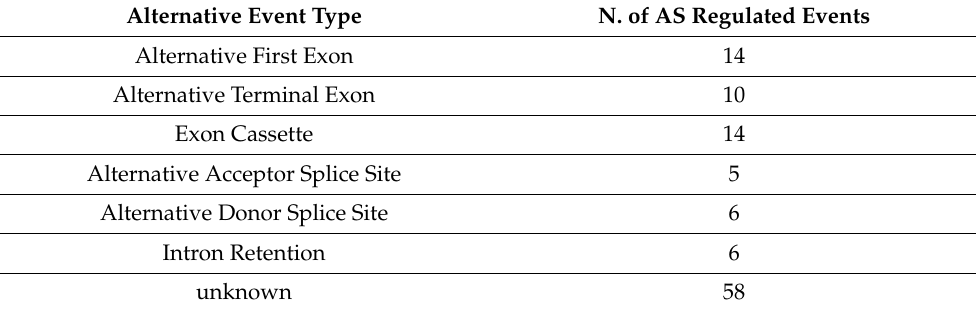
Table 2. Number of AS regulated